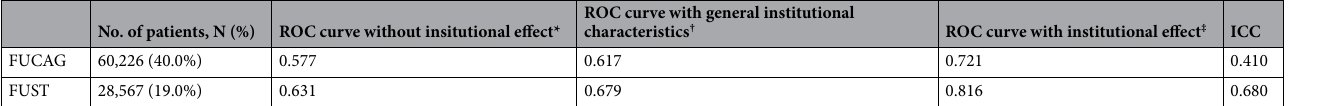
No. of patients, N (%) ROC curve without insitutional effect*